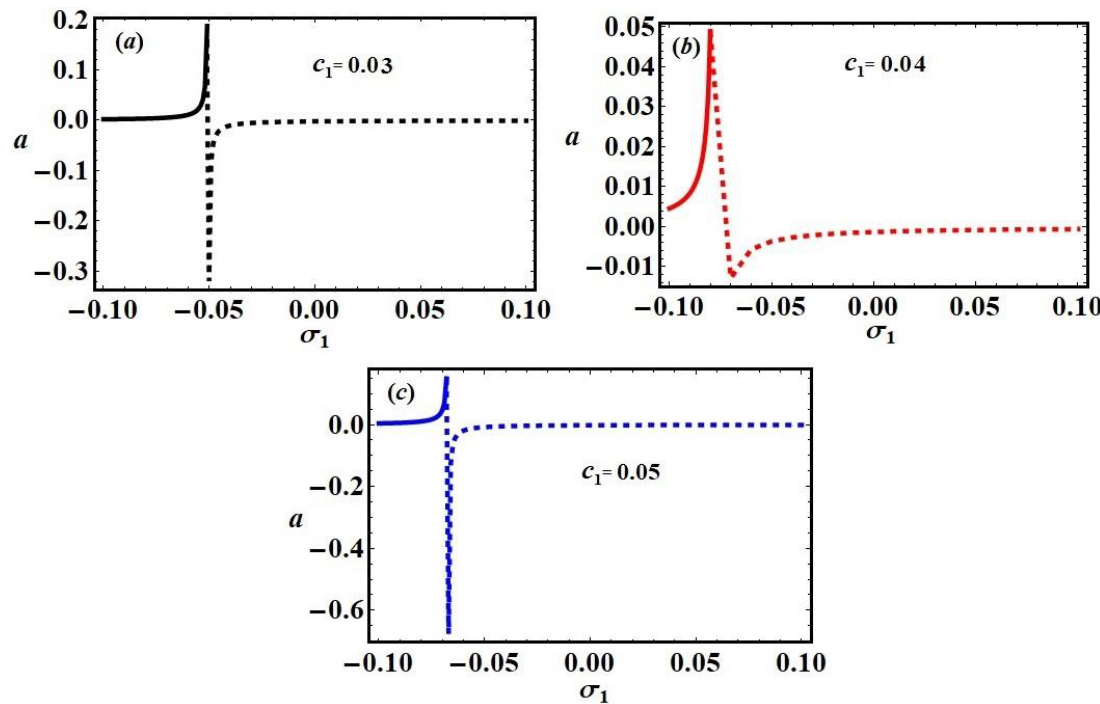
Figure 12. Frequency response curves of a at ω 1 = 2.5, σ 2 = 0.003: ( a ) c 1 = 0.03, ( b ) c 1 = 0.04, ( c ) c 1 = 0.05.